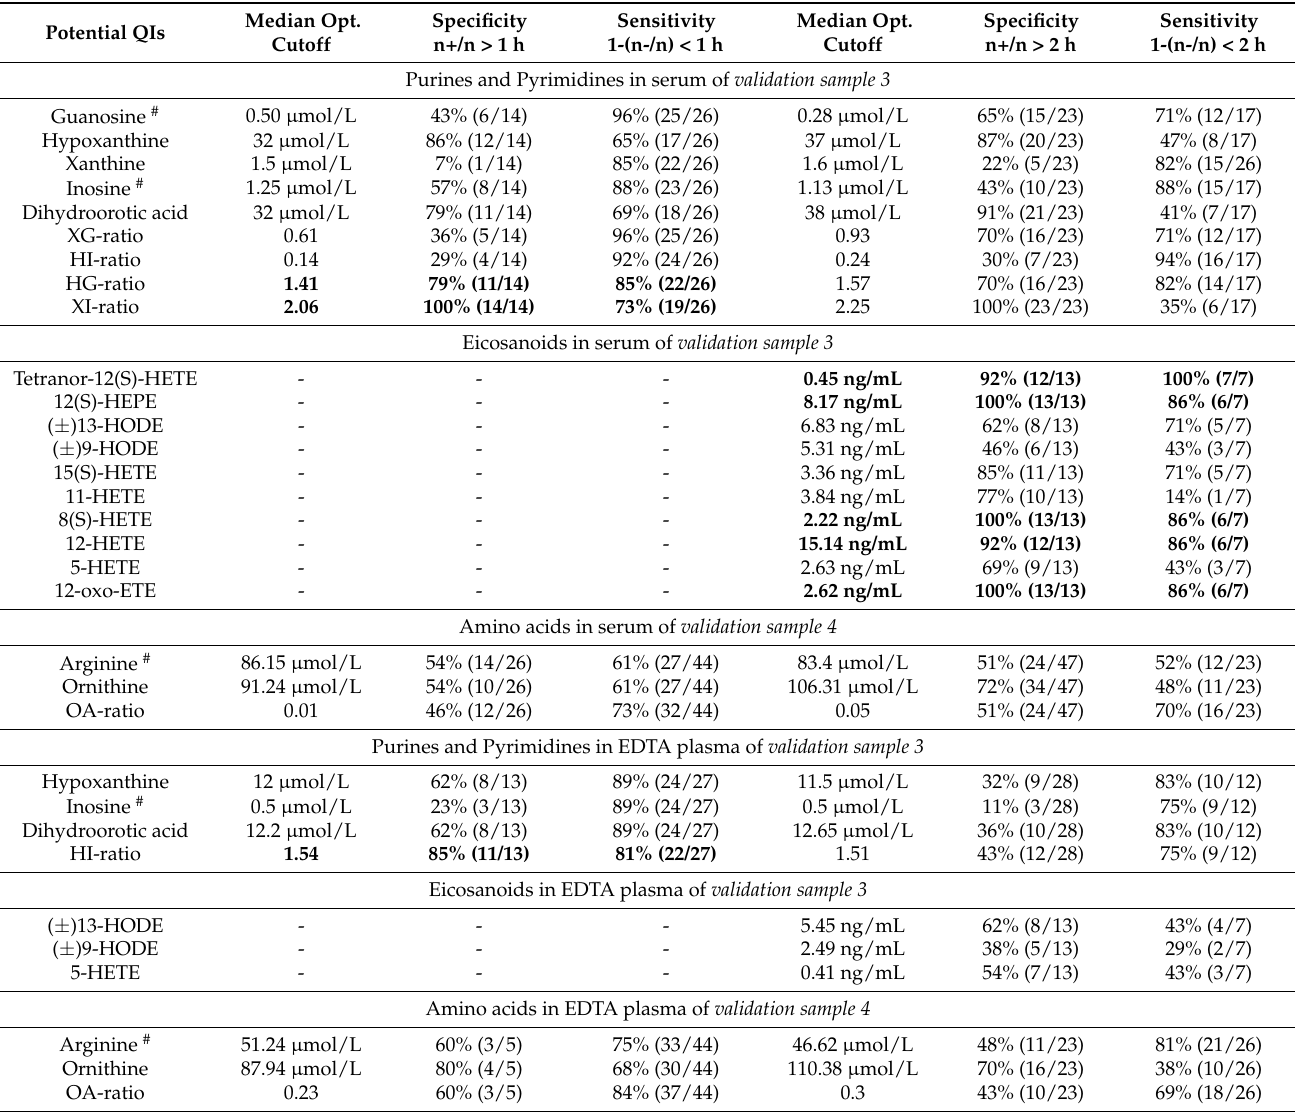
Table 2. Accuracy of all potential QIs for discrimination of TTC ≤ 1 h and 2 h in validation samples of patients with rheumatic and cardiovascular